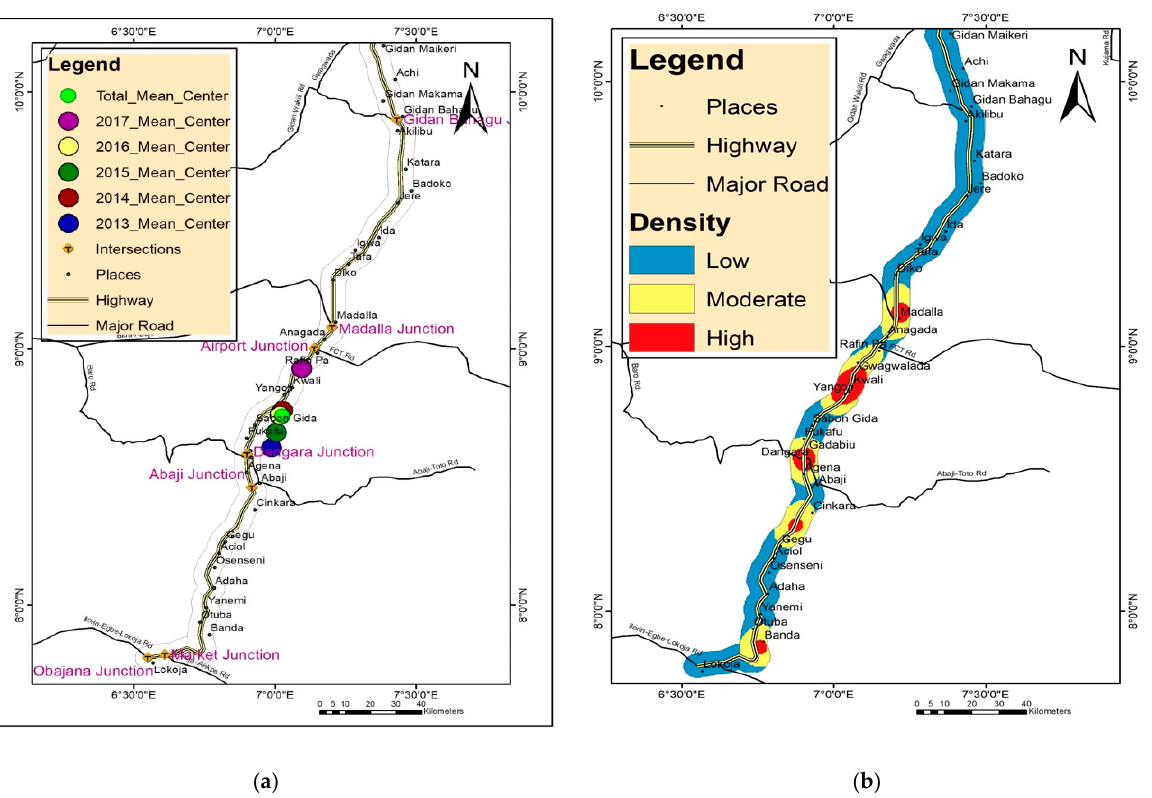
Figure 2. Results of weighted mean and total density. ( a ) Shift in geographical mean of accident frequency; ( b ) Total hotspot map for 2013–2017.